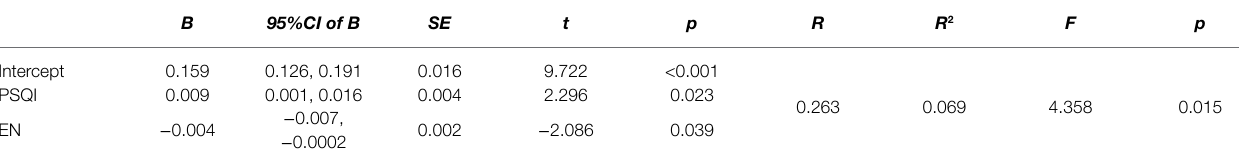
TABLE 4 | A multiple linear regression model with characters as the dependent variable.